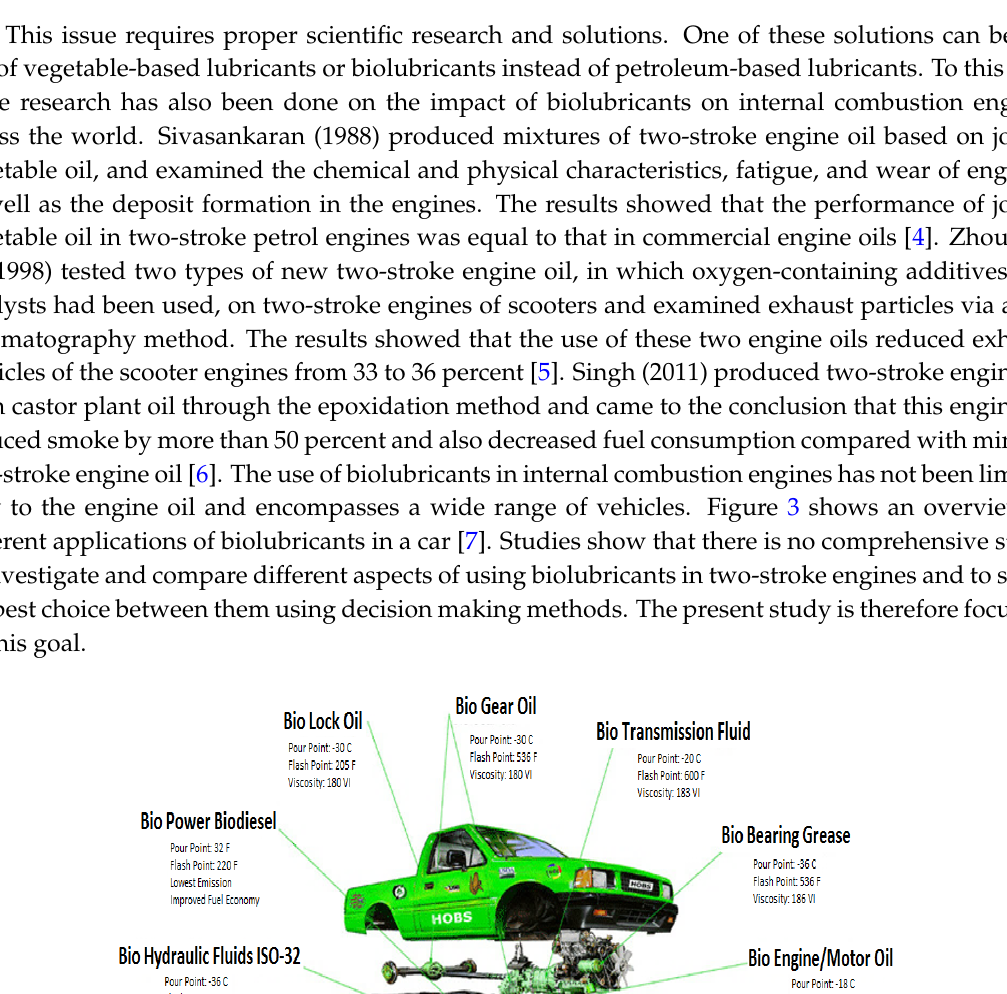
Figure 2. Lubrication with the help of the crank chamber in two ‐ stroke engines and creation of smoke .